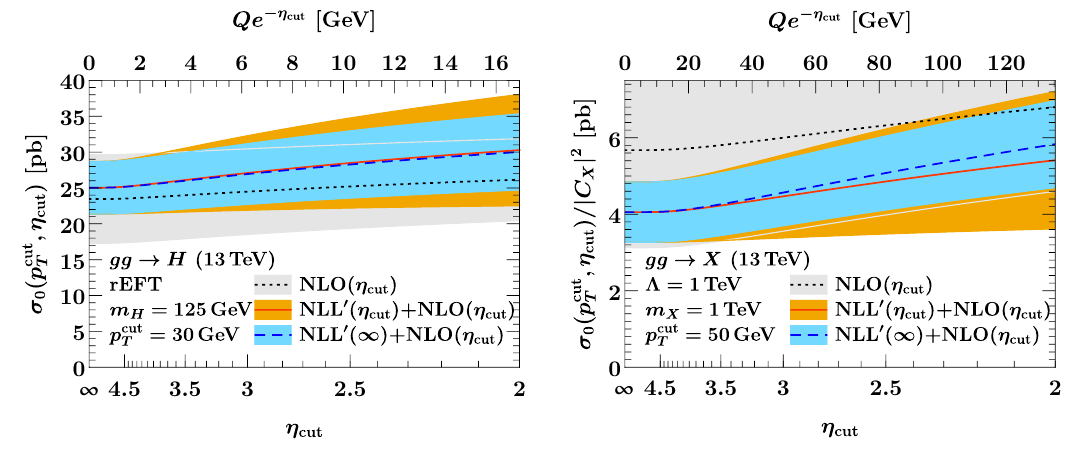
Figure 10 . The 0-jet cross section for gg gg X at m X = 1 TeV and p cut !